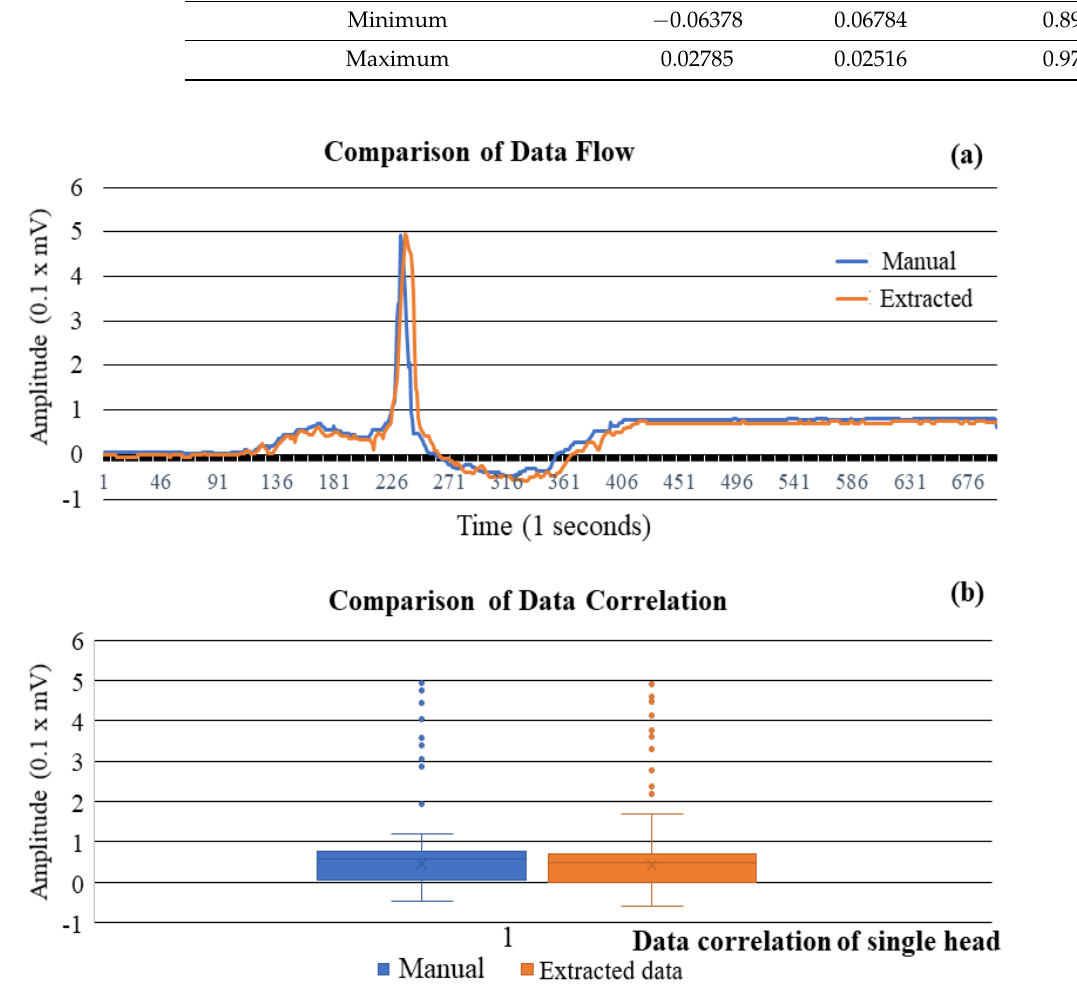
Figure 12. Data flow of the single-lead with the comparison of derived (extracted) data and manual (original) data: ( a ) data flow and ( b ) data correlation